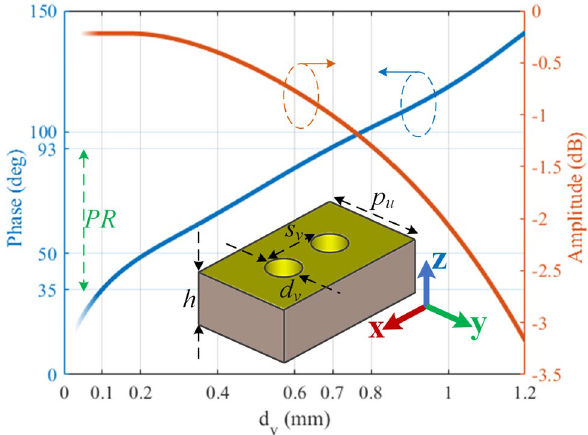
Figure 4. The geometry of the proposed unitcell and its simulated transmission characteristics at 30 GHz. Ports 1 and 2 are configured at the two faces of the unitcell normal to the x -axis.